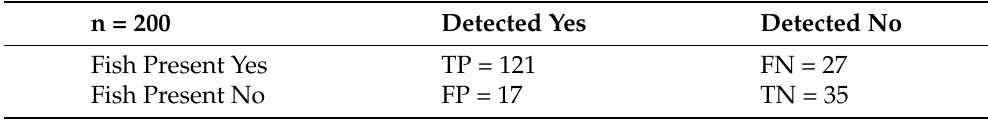
Table 2. Confusion matrix for fish detection.